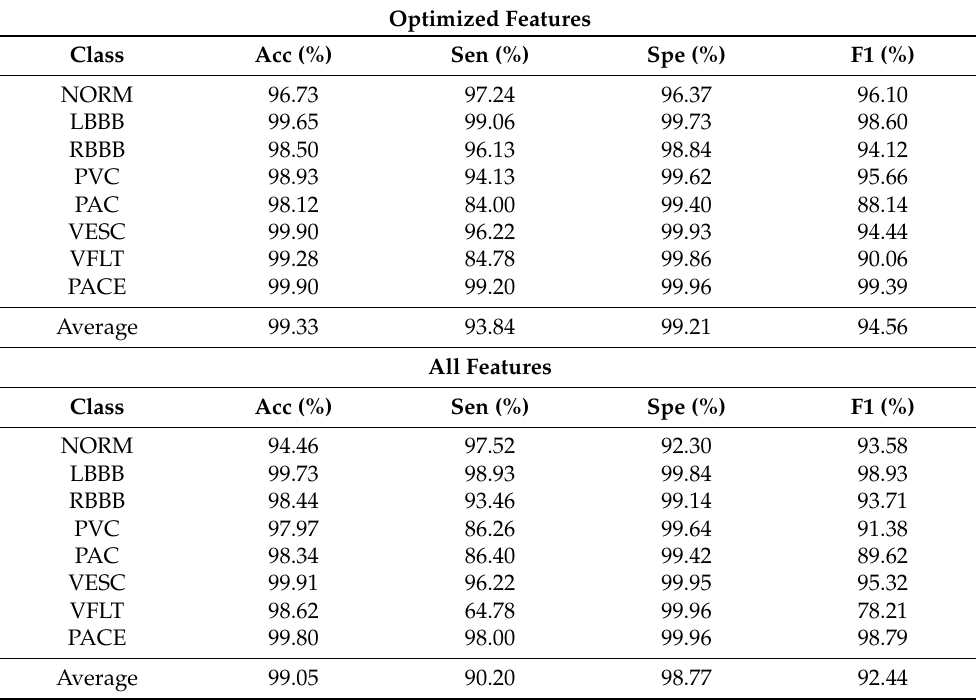
Table 5. Classification results for testing subset with Optimized and All features with fit = MCC for 1 normal and 7 arrhythmia